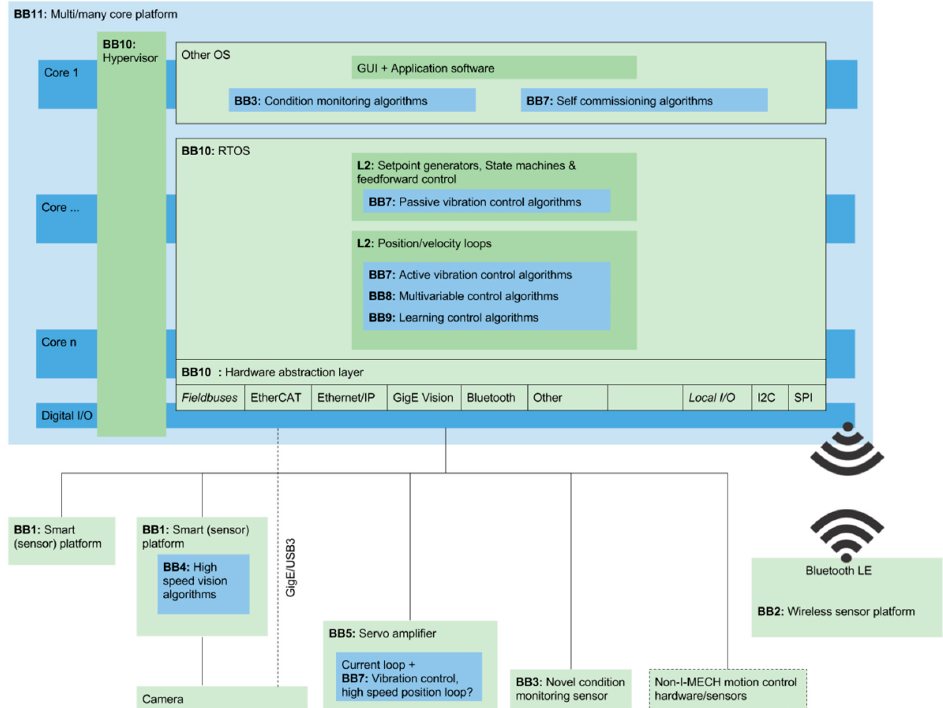
Figure 6. Motion control platform decomposition into BBs and Layers.